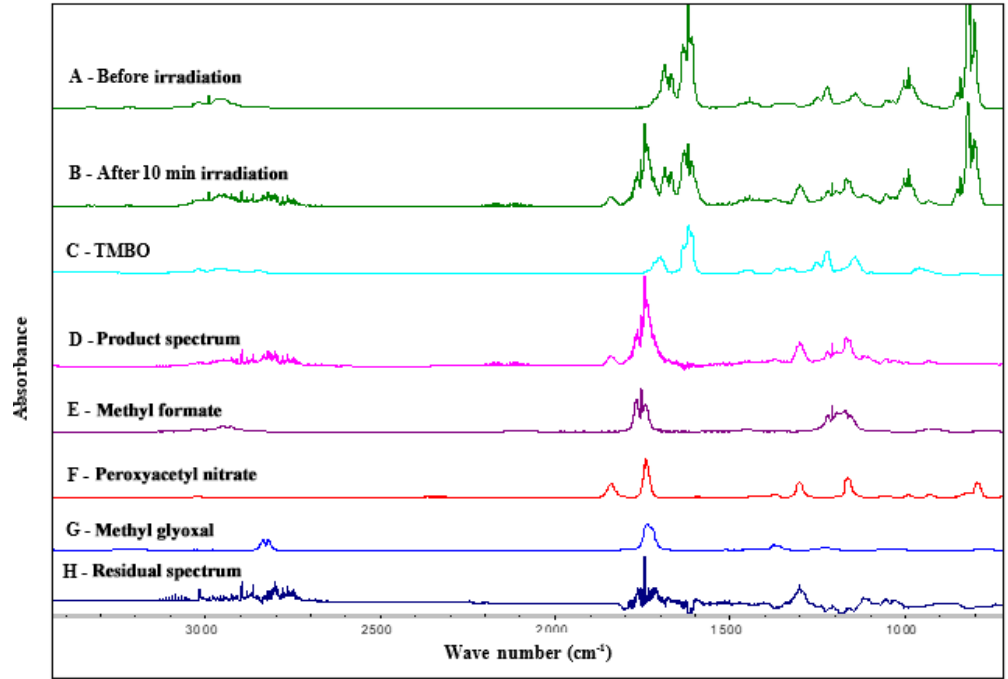
Figure 3. Infrared spectral data. Trace A: infrared spectrum of a TMBO / CH 3 ONO / air reaction mixture before irradiation. Trace B: mixture after 10min irradiation. Trace C: reference spectrum of TMBO. Trace D: product spectrum. Trace E: reference spectrum of methyl for- mate. Trace F: reference spectrum of peroxyacetyl nitrate. Trace G: reference spectrum of methyl glyoxal. Trace H: residual spectrum after subtraction of the identified reaction products in trace